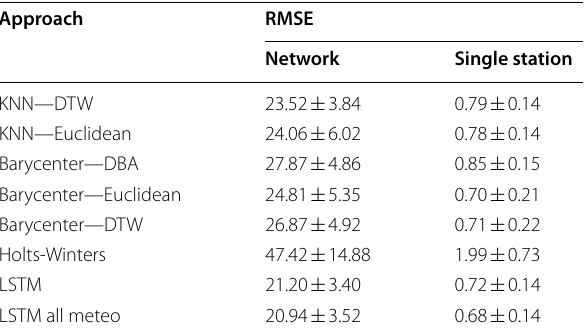
Table 1 Comparison of context-unaware versus context- unaware state-of-the-art approaches of time series forecasting: root mean squared error (RMSE) after rolling cross-validation associated with the forecasting of check-ins at GIRA’s network (all stations) and single stations—details in [35]